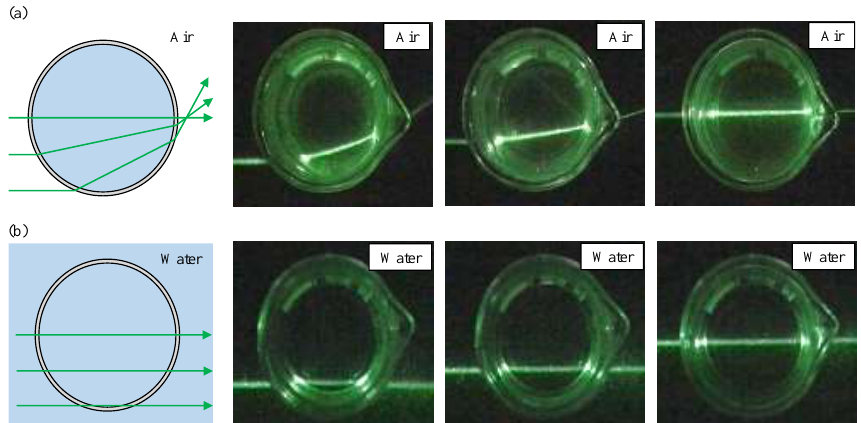
Figure 3. The path ways of parallel laser beams pass through a glass bottle. ( a ) The refraction of light without a water bath and ( b ) the refraction of light with a water